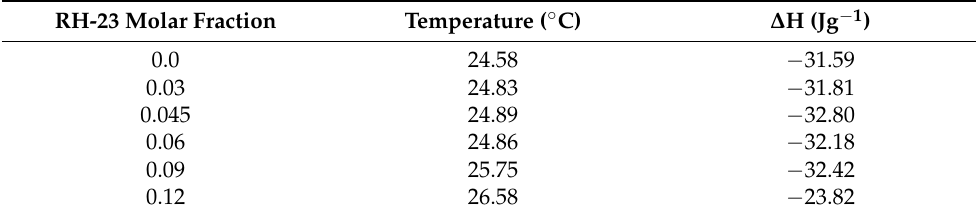
Table 1. Variations in temperature and enthalpy values ( ∆ H) of the transition peaks of MLVs in the absence and presence of RH-23 at increasing molar